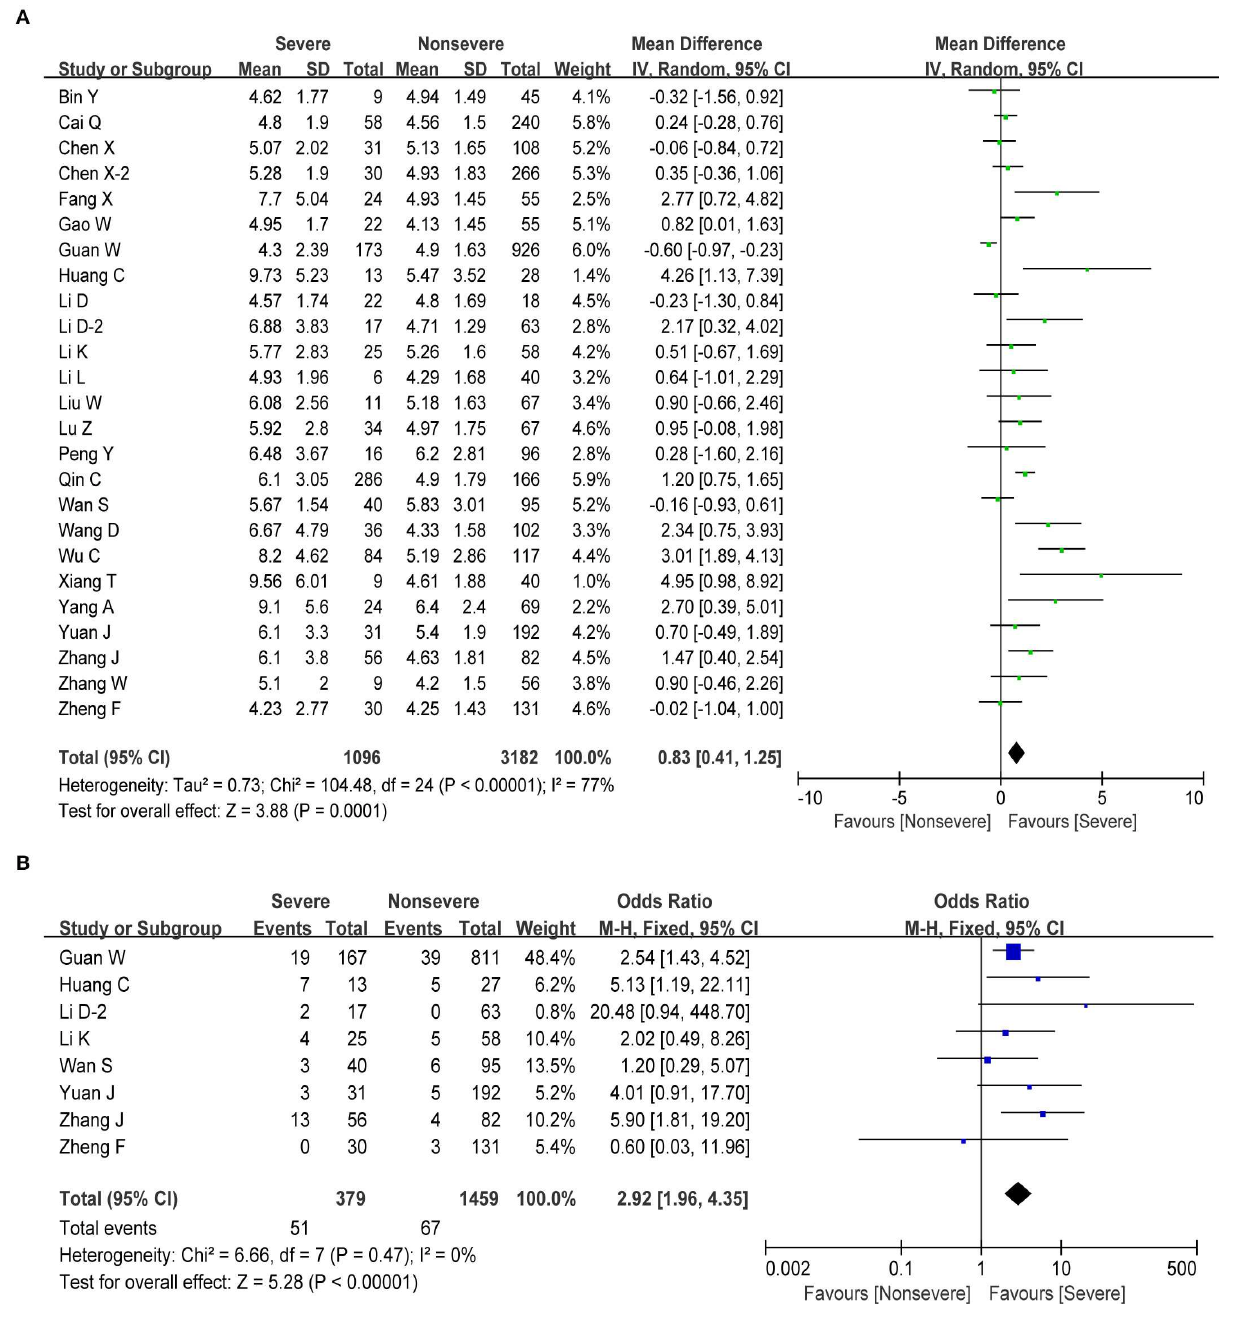
have a higher NLR than non-severe patients (MD = 0.85, 95% CI: 0.56–1.15, P < 0.001; Figure 4A ). At the same time, elevated NLR was significantly associated with increased disease severity with the pooled OR being 2.50 (95% CI: 2.04–3.06, P < 0.001; Figure 4B ), demonstrating that elevated NLR could be a predictor of disease progression in COVID-19